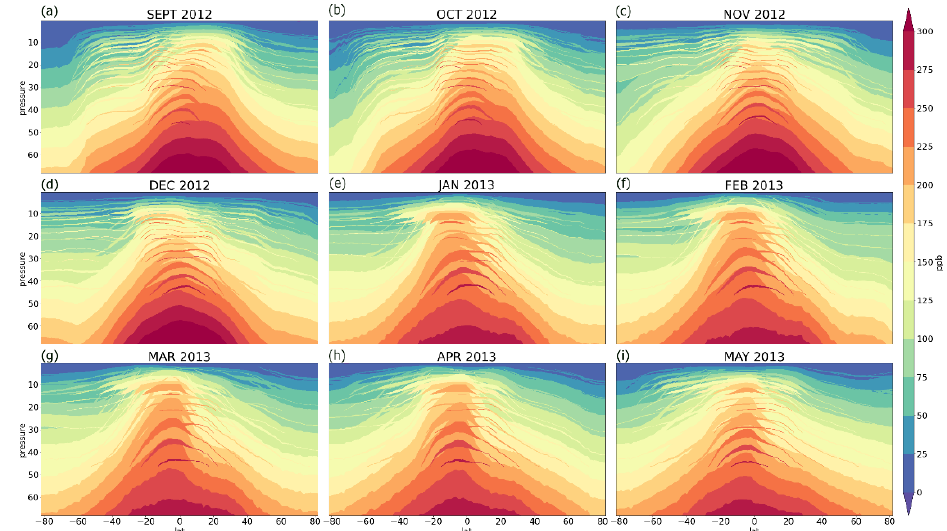
Figure 5. ( a – i ) Vertical profile of monthly zonal mean of N 2 O concentration from September 2012 to May 2013.